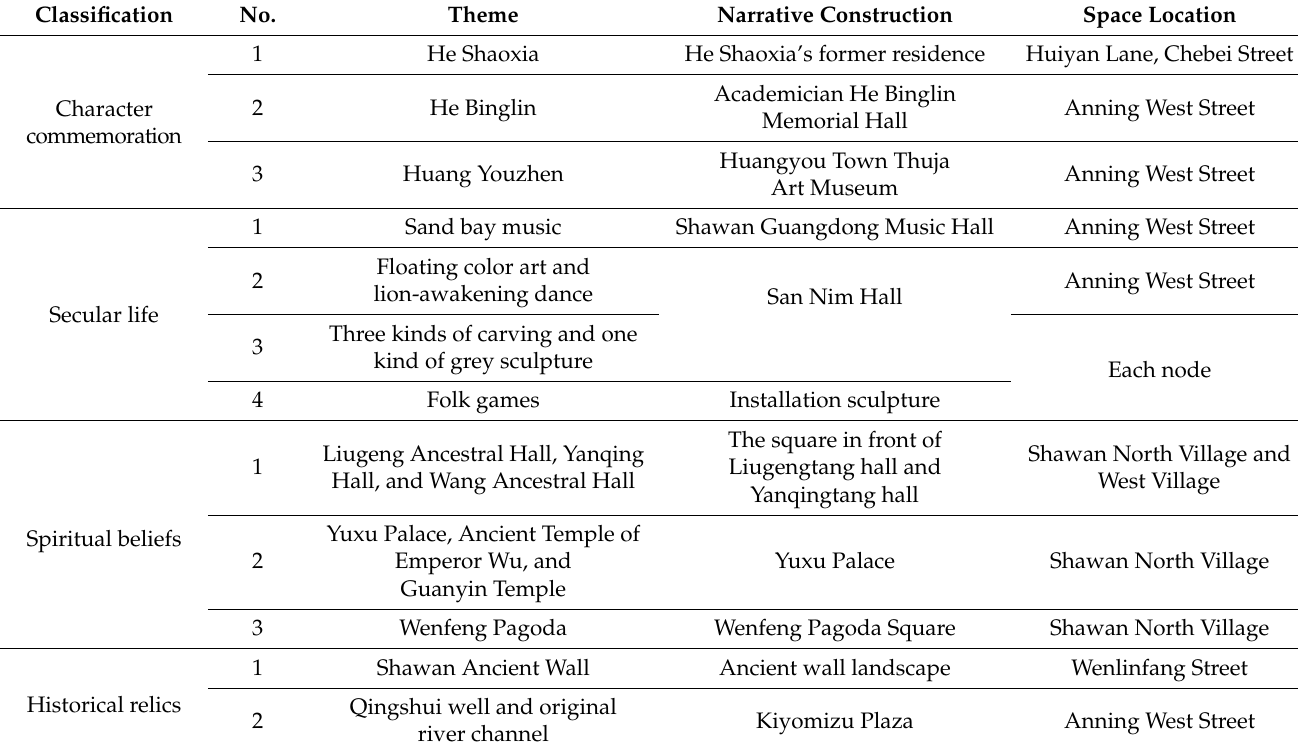
Table 1. Classification of narrative themes in Shawan Ancient